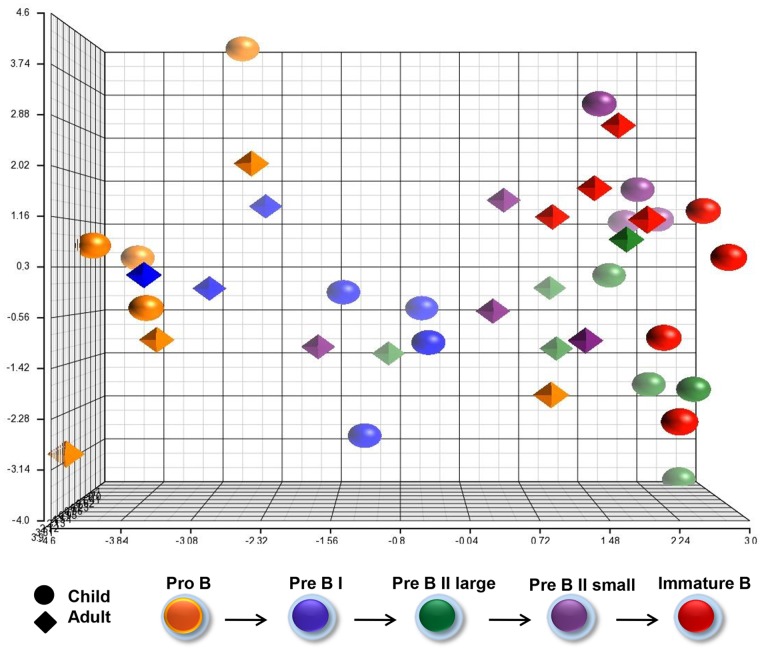
MicroRNA profiles of precursor B cell subsets.Principle component analysis (PCA) showing the overall expression pattern of 17 microRNAs (18 assays) that were at least once differentially expressed between the various subsets (FDR 10%, p≤0,004). The color codes indicating differentiation stage (right) and age group (left) are explained below.